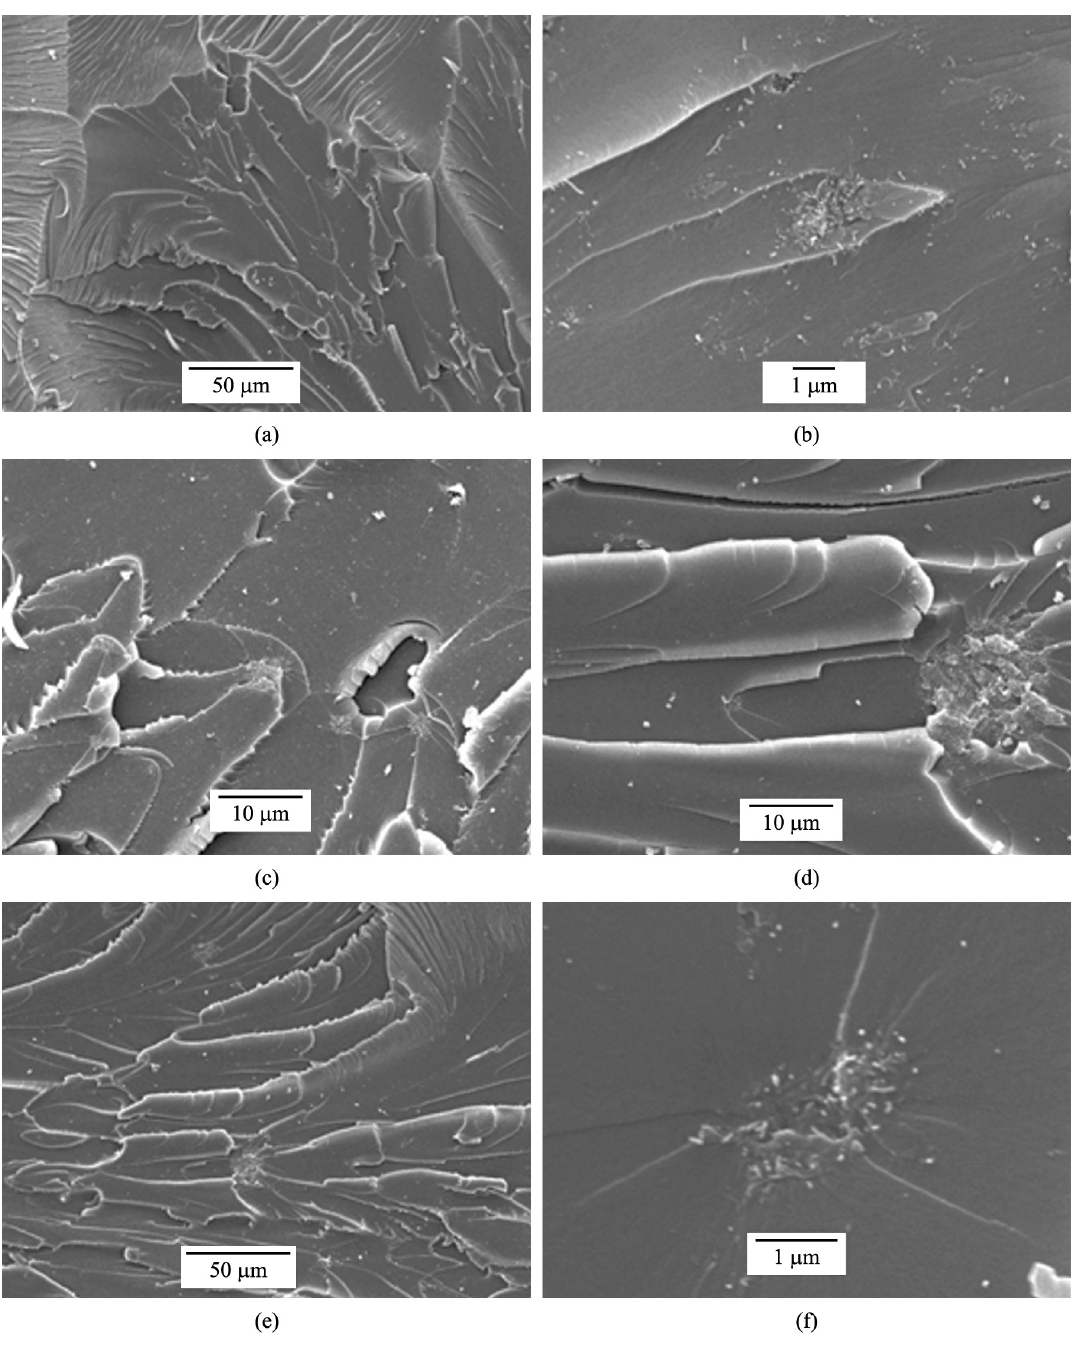
Figure 3. SEM images of fracture surface tensile: (a) LY; (b) LY-CNT; (c) LY-18-0-CNT; (d) LY-18-7-CNT; (e) LY-24-0-CNT; (f)